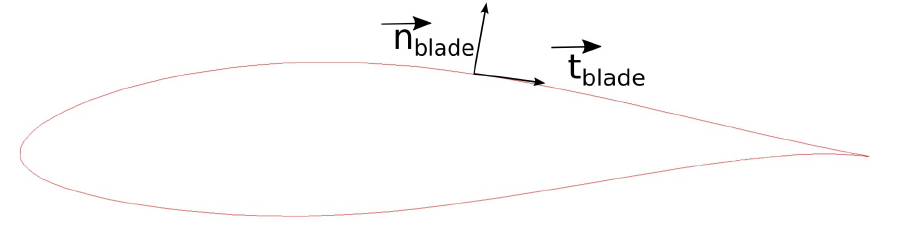
Figure 4. n blade and t blade for a blade profile (red line).